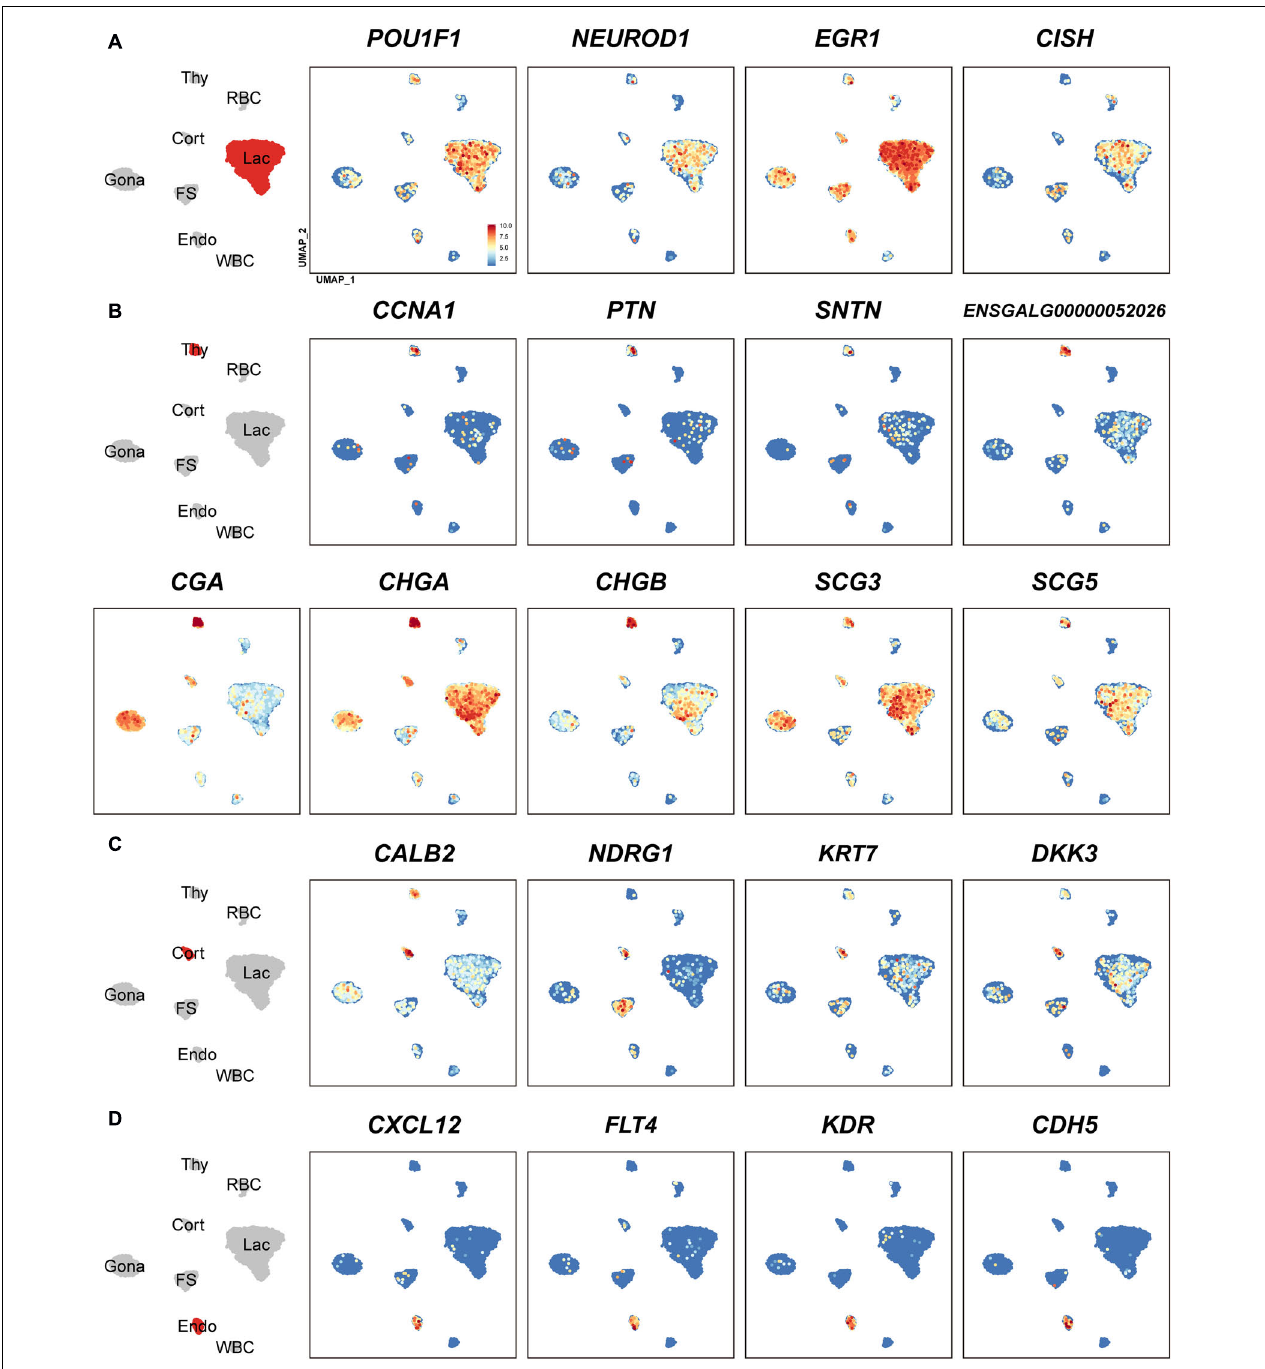
FIGURE 4 | Uniform Manifold Approximation and Projection (UMAP) maps showing the expression of some marker genes in lactotrophs ( A : Lac), thyrotrophs ( B : Thy), corticotrophs ( C : Cort), and endothelial cells ( D : Endo). Color bar indicates the relative expression level of each marker gene from the lowest expression (light blue dots) to highest expression (dark red